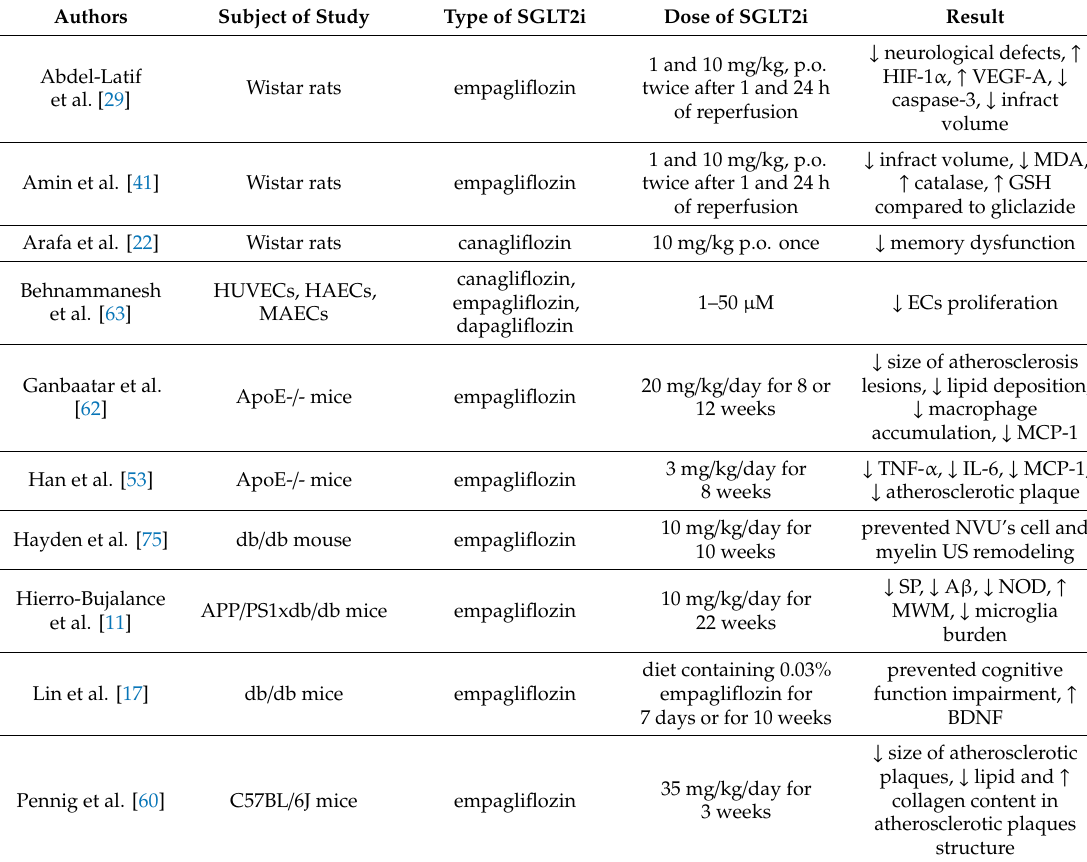
Table 1. Summary of reviewed